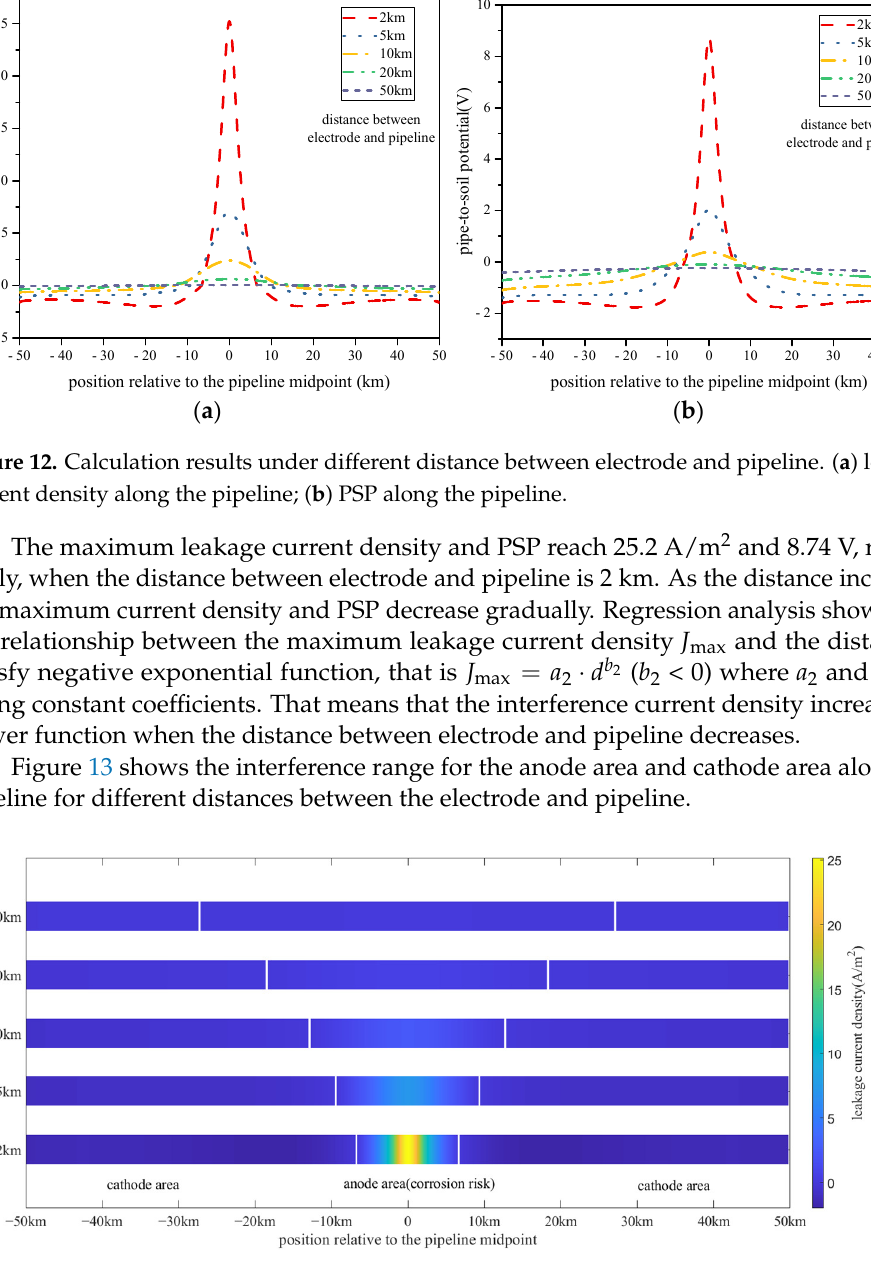
Figure 13. Corrosion risk area distribution for different distances between HVDC electrode and pipeline.